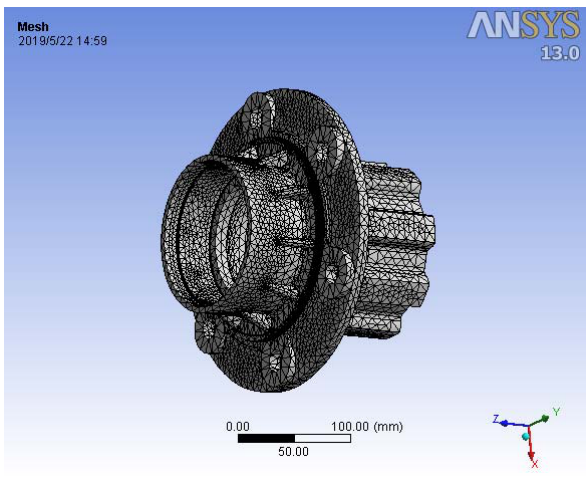
Figure 9. Lightweight design scheme.